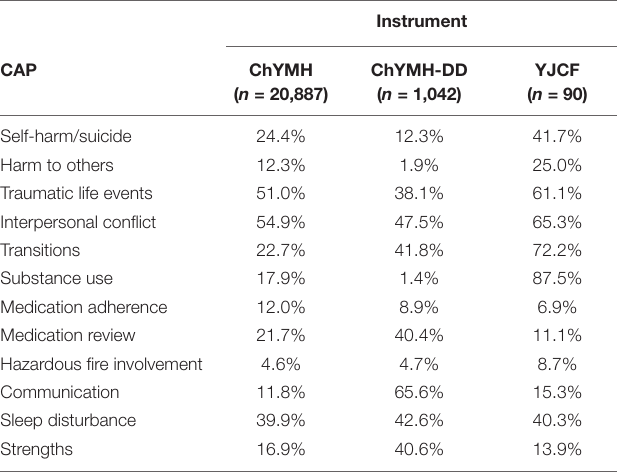
TABLE 6 | List of selected CAPs and their triggering rates across three child/youth mental health instruments.